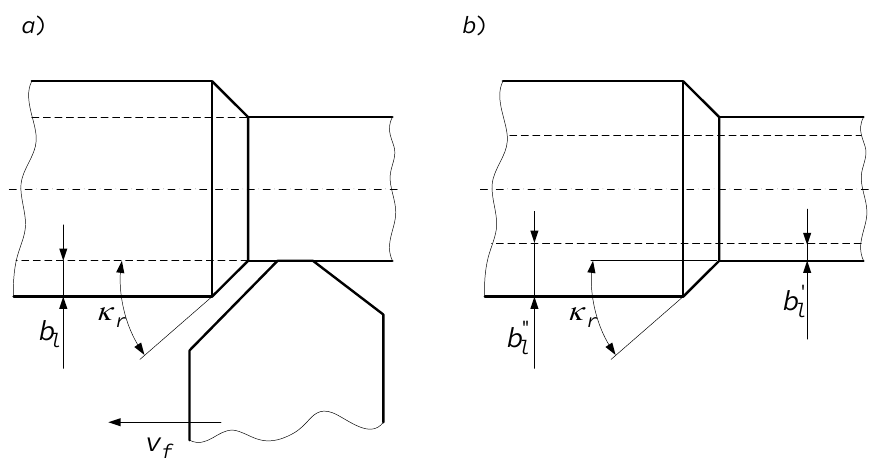
Figure 7. Sketches of the blanks used to determine the transition function: ( a ) under longitudinal feed control, ( b ) under interference in the form of change in allowance.